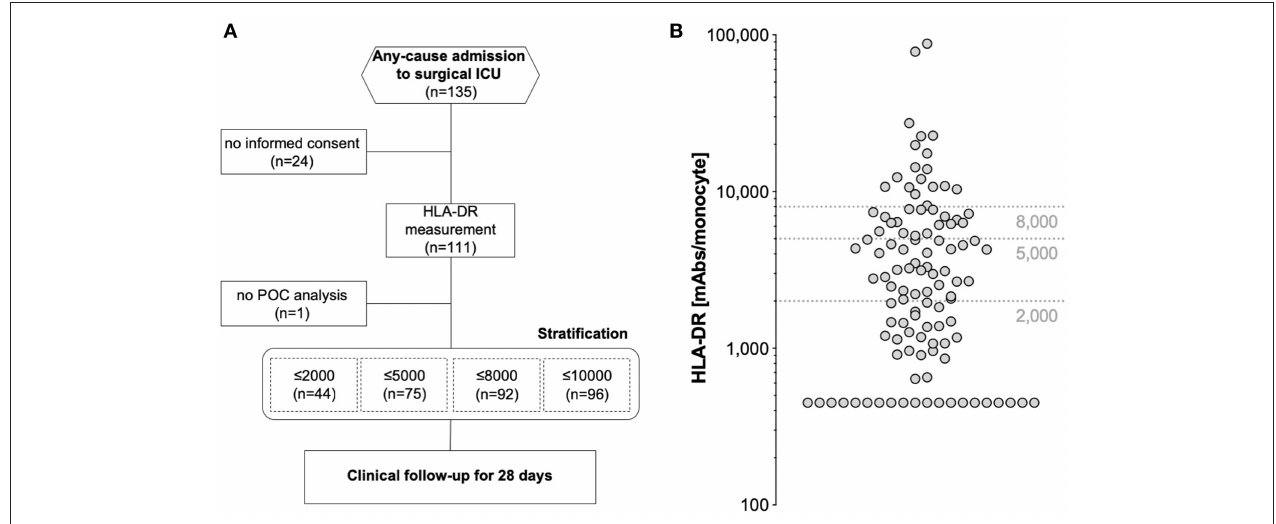
FIGURE 1 | (A) Study flowchart according to STROBE and (B) distribution of HLA-DR measurements in the analyzed study cohort of 110 patients. Dashed horizontal lines depict threshold values indicated in earlier